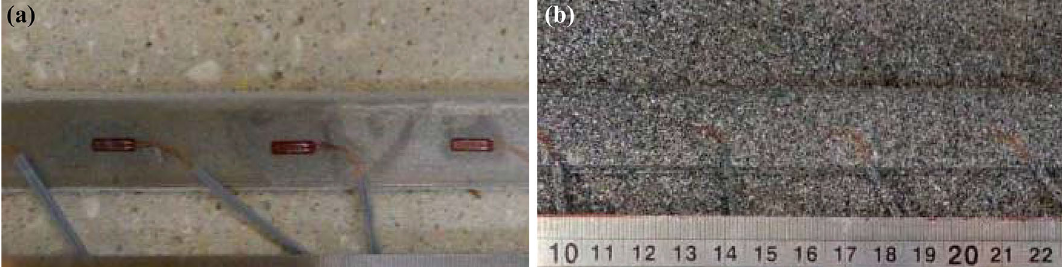
Fig. 4 The concrete surface to be monitored during the test: a before; and b after spraying with